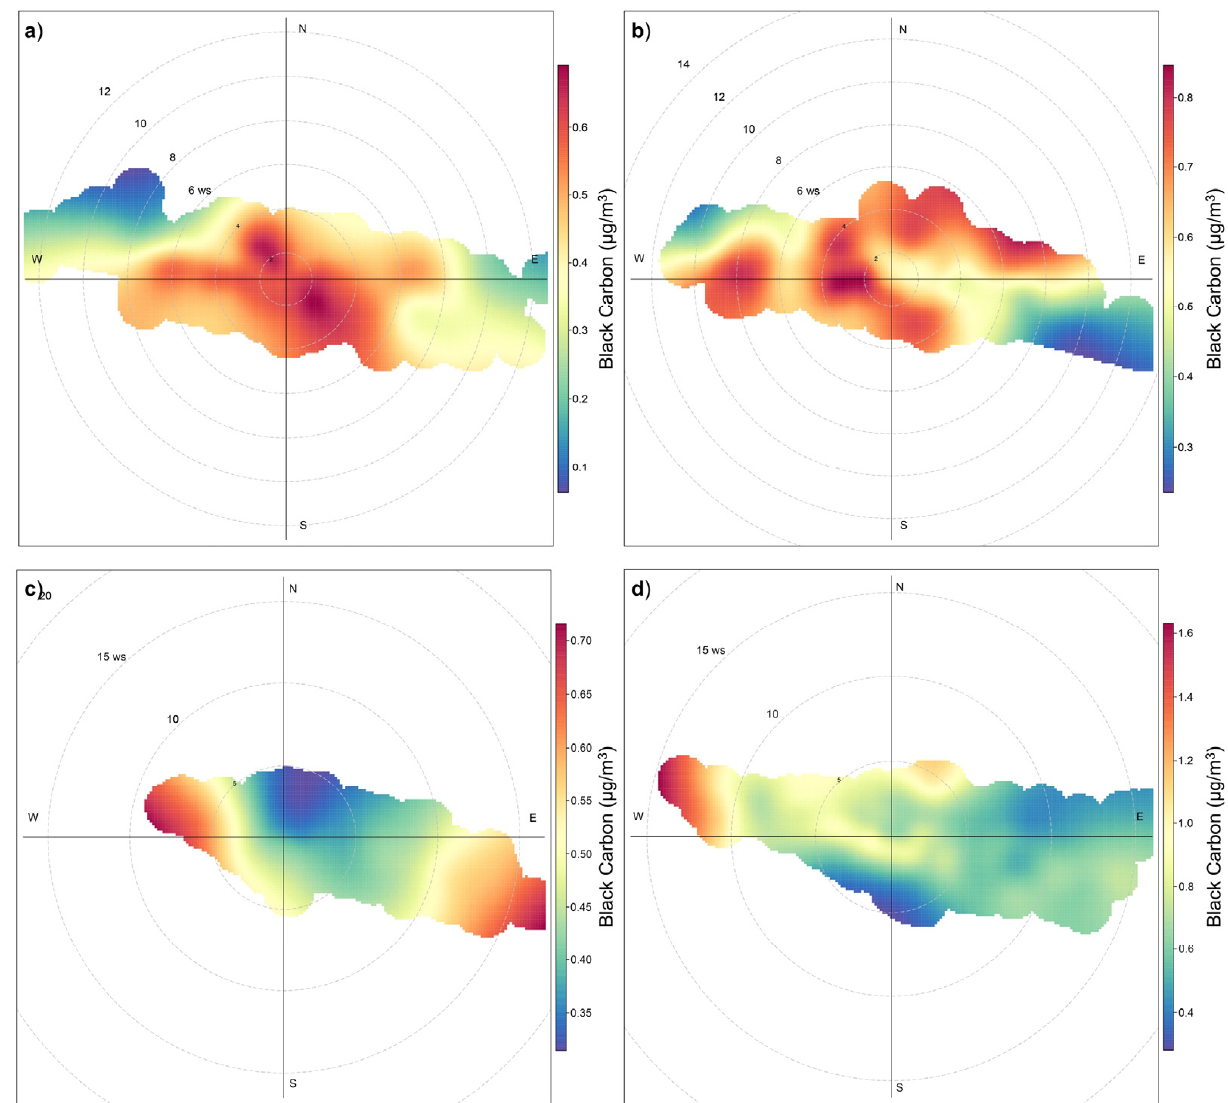
Figure 6. Polar plots of BC concentrations over ALTZ: ( a ) S1, ( b ) S2, ( c ) S3 and ( d ) S4.